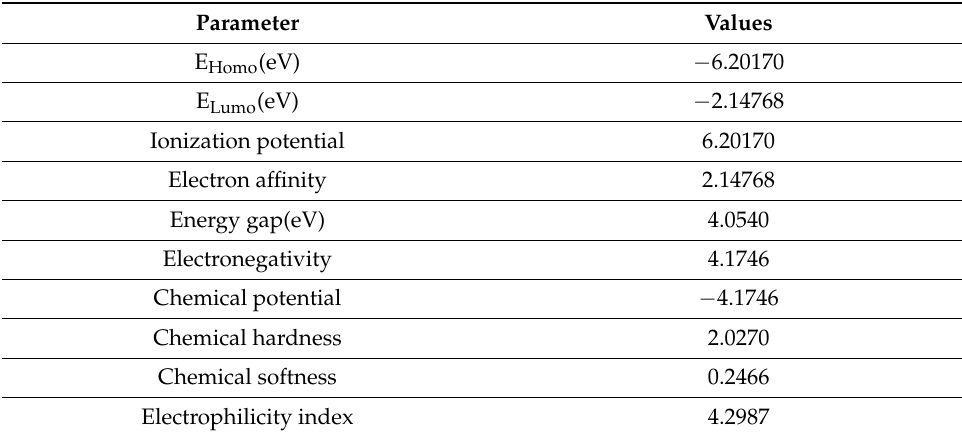
Figure 8. ( a ) Theoretical and ( b ) experimental UV ‐ vis spectra of 21HBMBA. Table 4. Calculated energy values of 21HBMBA by B3LYP/6 ‐ 311++G(d,p) method.